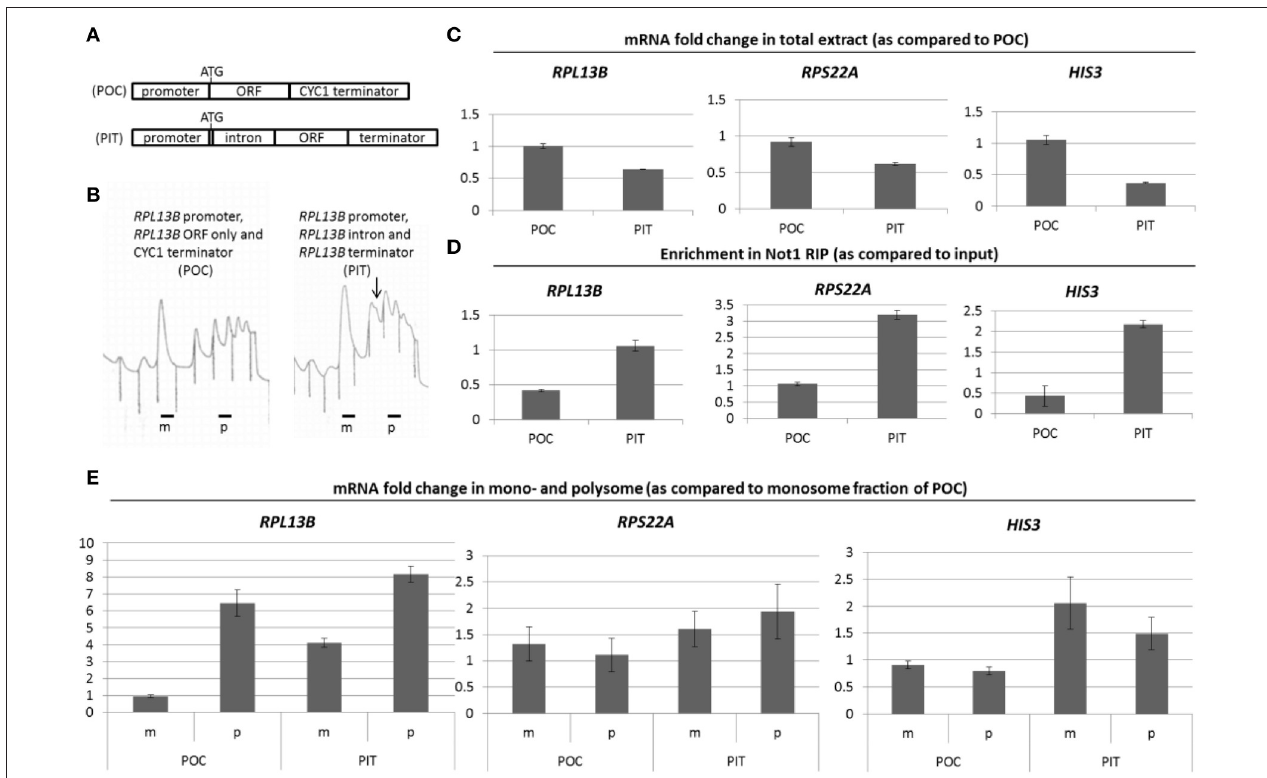
FIGURE 1 | (A) RPL13B constructs. Similarly to the majority of yeast RP genes with introns, in the case of RPL13B the entire ORF is encoded in the 2nd exon except for a methionine which is encoded in the 1st exon. Construct “PIT” contains all the endogenous elements of the RPL13B gene. The intron is removed and the terminator is changed to a CYC1 terminator in “POC.” (B) Extracts from cells expressing PIT or POC were separated on a sucrose gradient to follow the polysome profiles. The arrow points to a shoulder on the disome peak. (C,D) Levels of the indicated mRNAs were measured in total extracts (C) or in Not1 immunoprecipitates (D) . (E) Levels of the indicated mRNAs were measured in the monosome (m) and polysome (p) fractions as previously described ( Gupta et al., 2016). The specific mRNAs measured are RPL13B , RPS22A, and HIS3 as indicated, and normalization was to the NIP1 mRNA